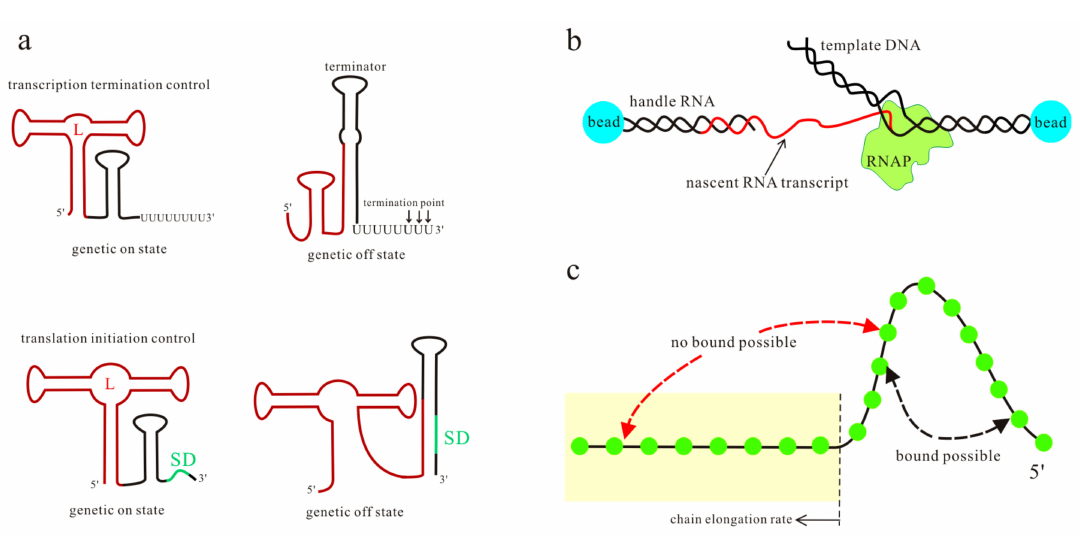
Figure 1. The transcription and translation control mechanisms of riboswitches ( a ), where the aptamer sequence and Shine–Dalgarno (SD) sequence are colored brown and green respectively; L is the ligand. A schematic of the optical-trapping assay and the kinetic Monte Carlo simulation is shown in ( b , c ). In ( c ), nucleotides (green circles) out of the tube (yellow) are possible to form base pairs. The kinetic Monte Carlo method grows the RNA chain with a constant rate, allowing more and more base pairs to form or open in the available